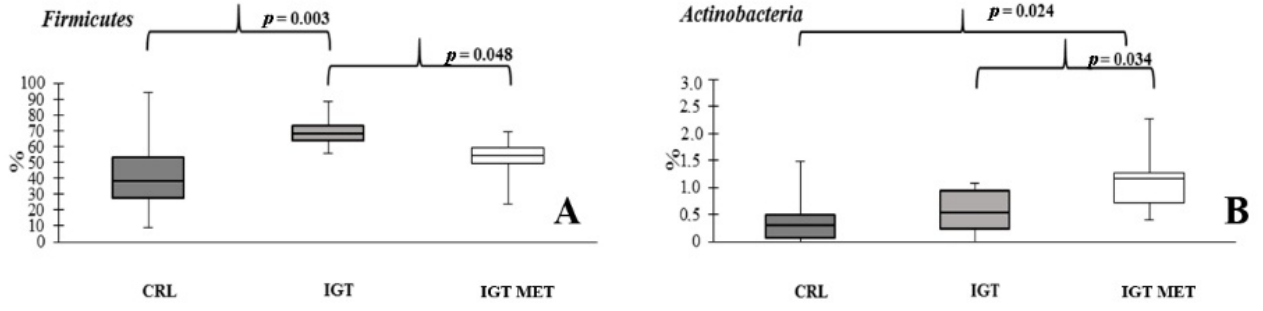
Figure 7. Relative abundances of phylums Firmicutes ( A ) and Actinobacteria ( B ) in the fecal samples of rats from different groups. CRL—control group, IGT—impaired glucose tolerance group, IGT MET—impaired glucose tolerance + metformin group.